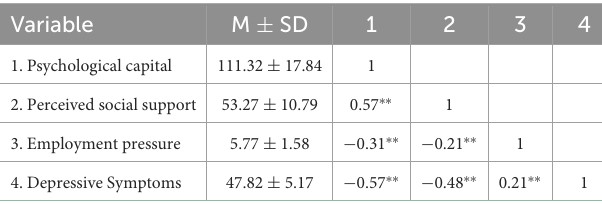
TABLE 2 Means, standard deviations, and correlations among study